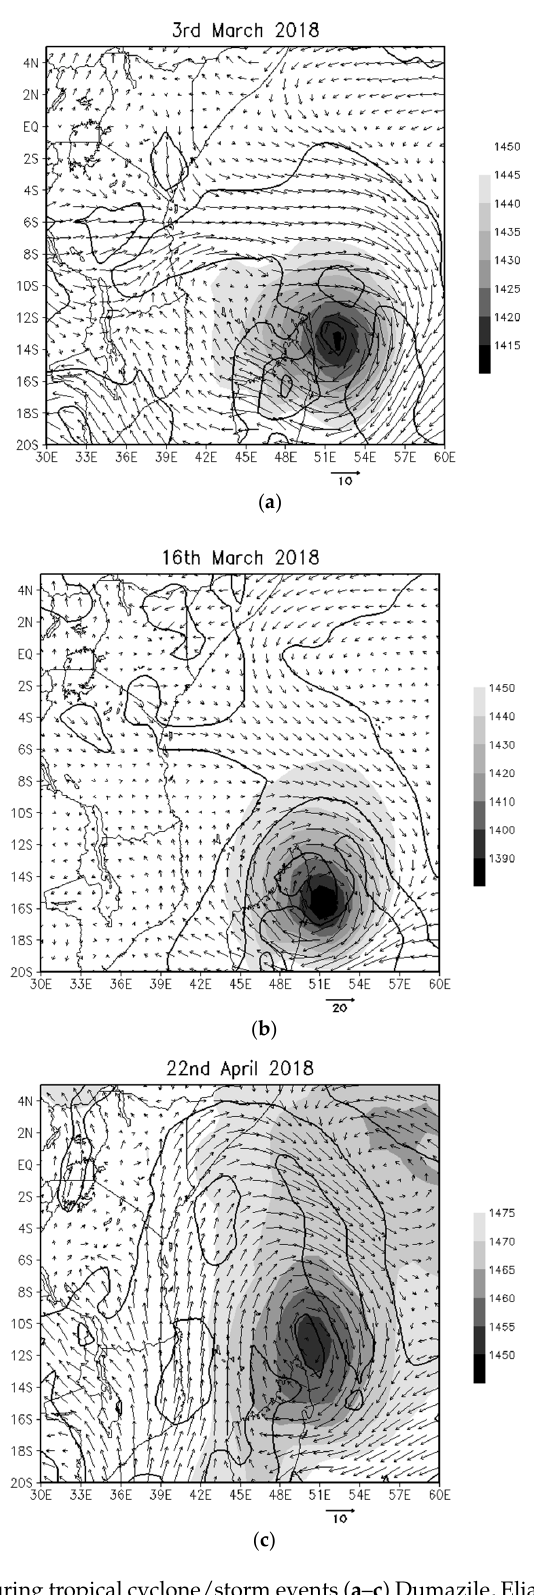
Figure 8. Circulation during tropical cyclone/storm events ( a – c ) Dumazile, Eliakim, and Fakir showing low-level (850 hPa) geopotential height, wind vectors, and speed (contours five, 10, and 15 ms − 1 ) from ERA-Interim for the days when the disturbance to the zonal flow at the equator over Kenya and the adjacent Indian Ocean is most pronounced.